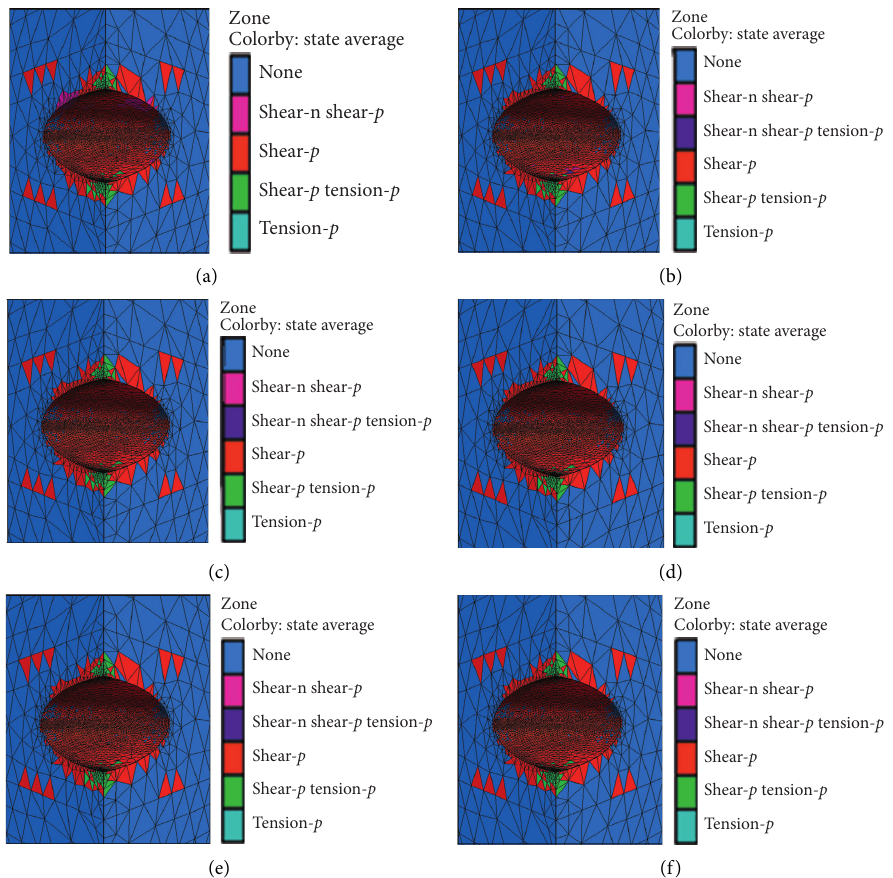
Figure 10: Variation of plastic zone of single-cavern horizontal salt rock underground storage when diameter-to-height ratio is N � 2.5 with operation time. (a) 1 a ; (b) 3 a ; (c) 5 a ; (d) 10 a ; (e) 15 a ; and (f) 20 a